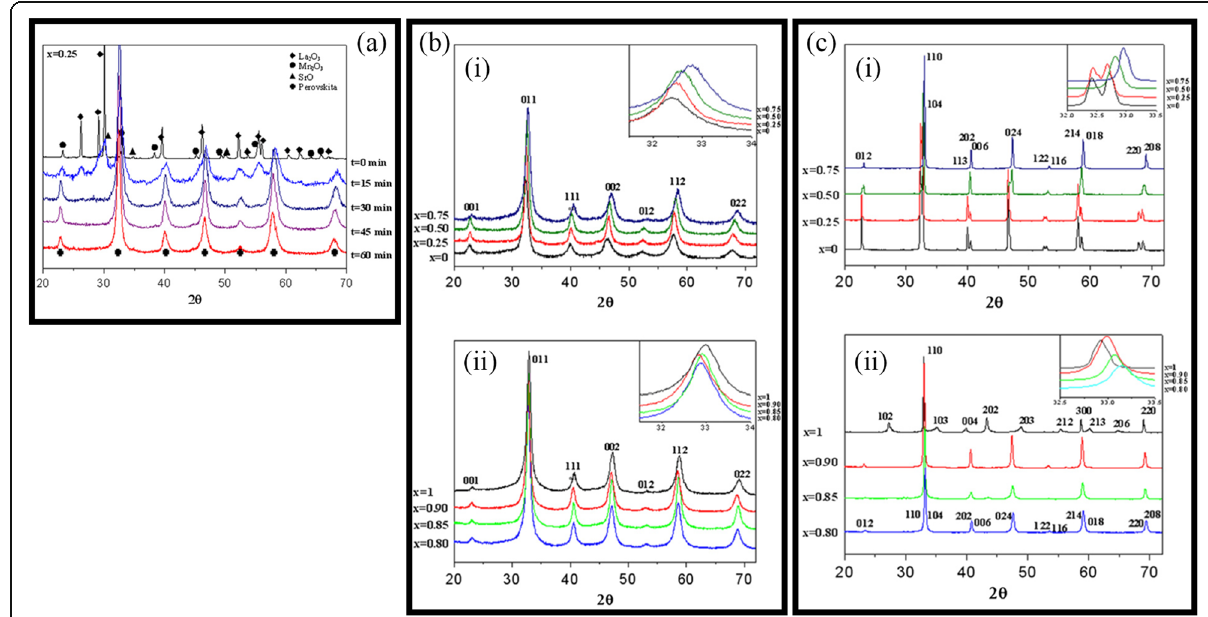
Fig. 3 a XRD patterns of the La 1-x Sr x MnO 3± δ ( x = 0.25) nanoparticles synthesized by mechanochemistry method under different milling time. b XRD patterns of the La 1-x Sr x MnO 3± δ (0 ≤ × ≤ 1) nanoparticles with different substitutions of La by Sr modifiers. c XRD patterns of the La 1-x Sr x MnO 3± δ (0 ≤ × ≤ 1) nanoparticles heat treated at 1000 o C under static air. (i) x = 0, 0.25, 0.50, and 0.75, and (ii) x = 0.80, 0.85, 0.90, and